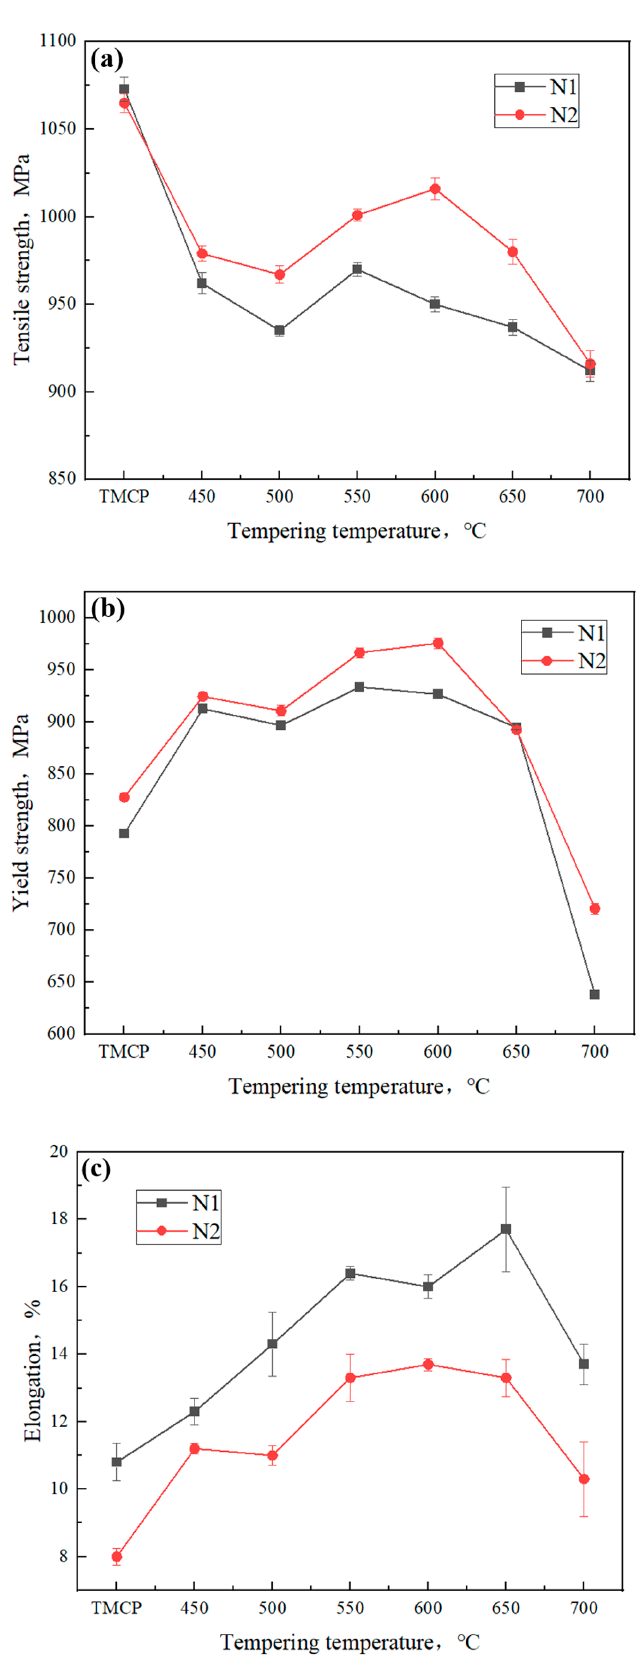
Figure 7. Mechanical properties of N1 and N2 steels under different tempering temperature: ( a ) tensile strength; ( b ) yield strength; ( c )